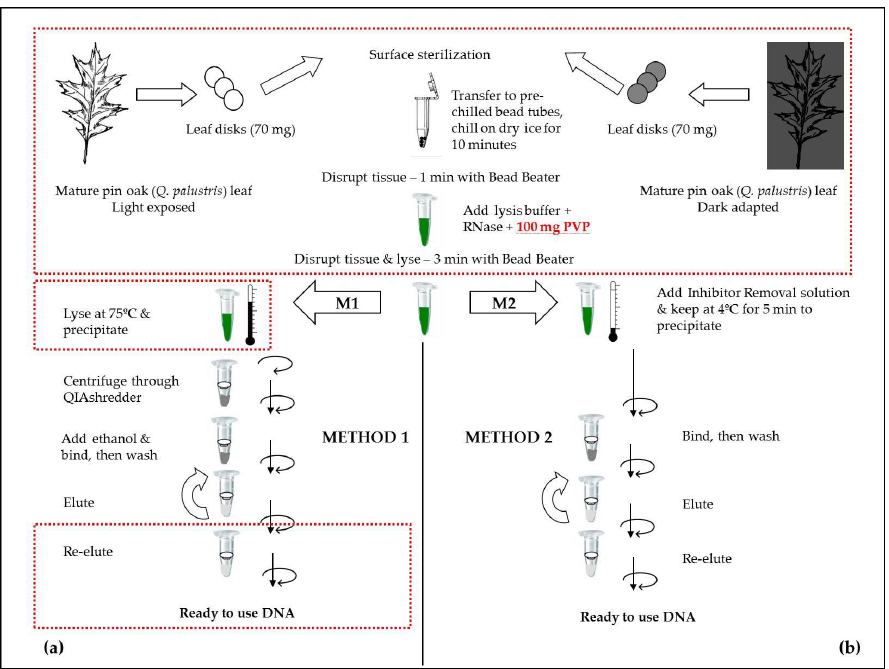
Figure 1. Schematic design of the methods adapted to extract genomic DNA from light or dark-adapted pin oak ( Q. palustris ) leaves or leaves of other species rich in polysaccharides and secondary metabolites: ( a ) M1, using CTAB (based on Qiagen DNeasy Plant DNA extraction kit) and ( b ) M2, using phenol (based on MoBio Power Plant DNA extraction kit) for contaminant removal. Red box framing indicates steps specifically modified within this work, differing from kit manufacturer